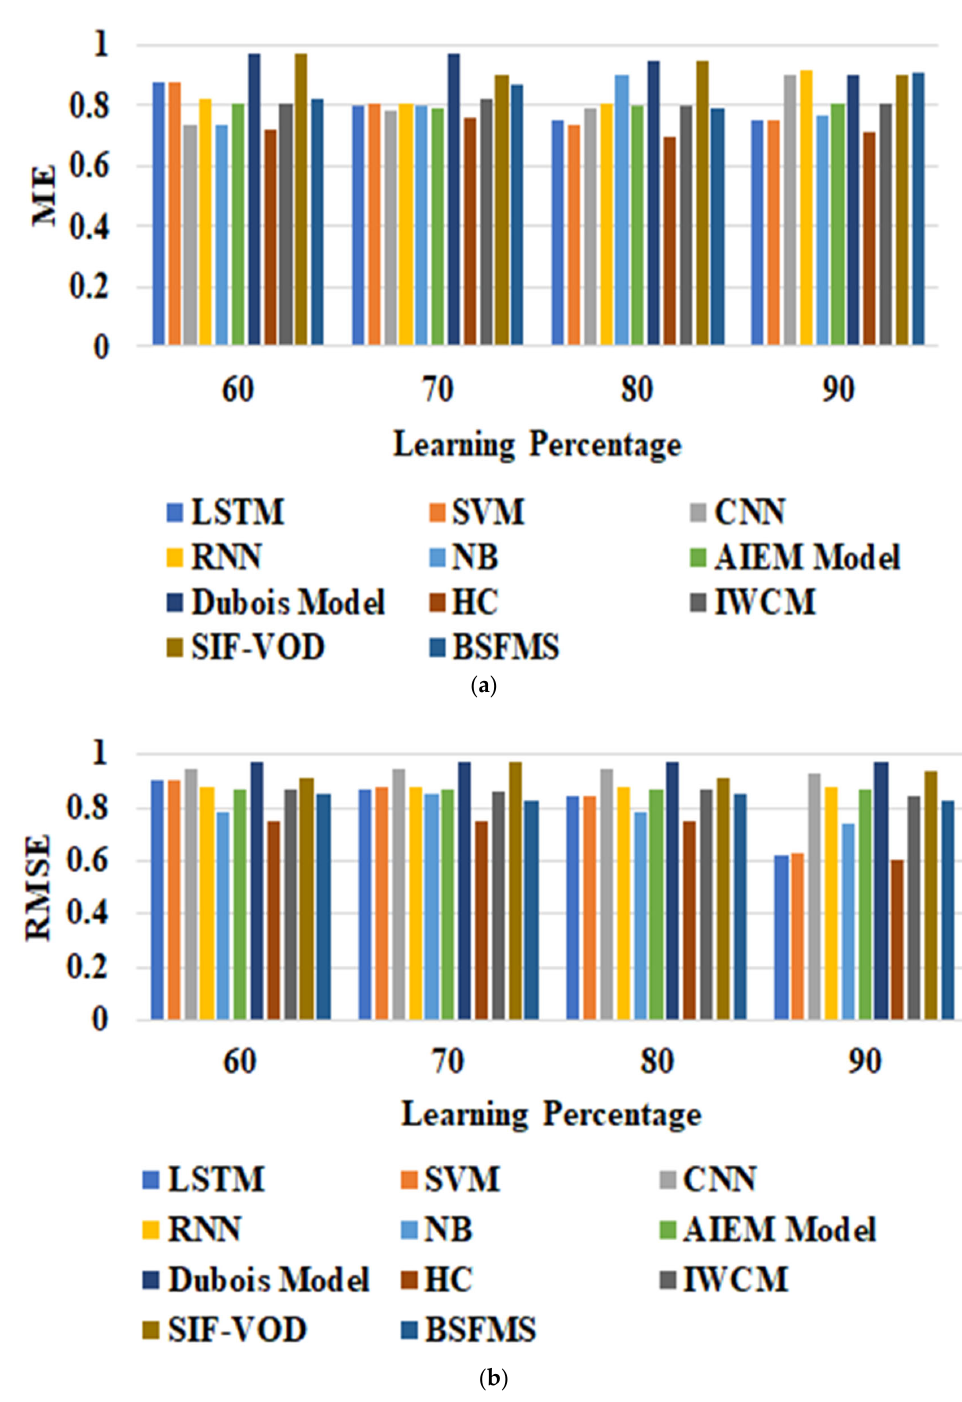
Figure 3. Analysis of HC (Bi ‐ GRU and DMN) over conventional methods ([21,24,28,37,41]) for ( a ) estimated error, ( b ) MAPE, and ( c ) MARE.